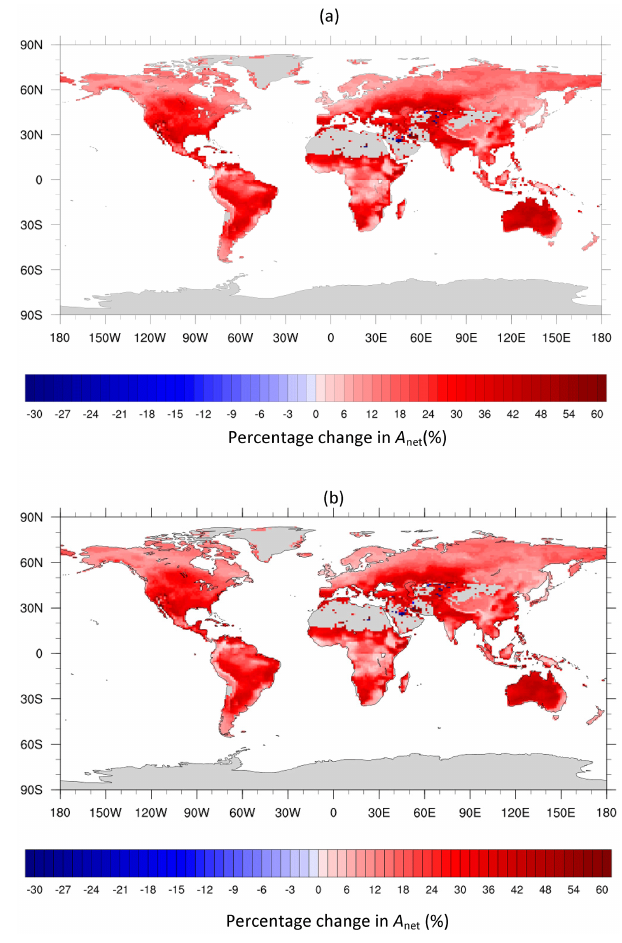
Figure 7. Percentage differences in estimated net photosyn- thetic rate for the leaf layer at the top of the canopy ( A net , µmolCO 2 m − 2 s − 1 ) under future climate conditions ( a : TRF1, b : TRF2) by using LUNA predicted values of V c,max25 (µmol CO 2 m − 2 s − 1 ) and J max25 (µmolelectronm − 2 s − 1 ) under historic versus future climate conditions. Positive values indicate overesti- mation by using fixed (or historic) V c,max25 and J max25 while neg- ative values indicate underestimation. The historic climate is repre- sented by the 10-year monthly averages over years 1995–2004 and the future climate is represented by the 10-year monthly averages over years